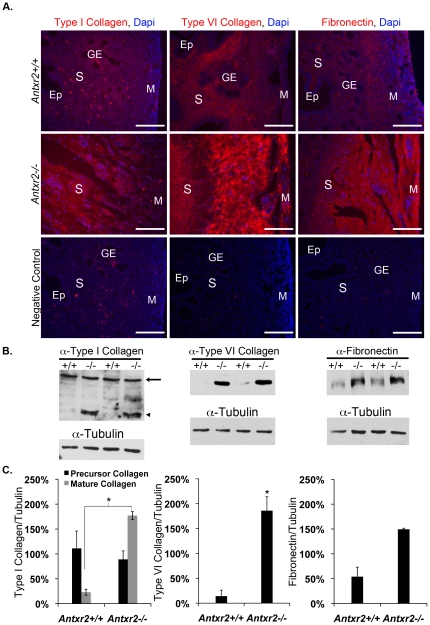
Increased collagen and fibronectin content in aged nulliparous Antxr2−/− uterine tissue.(A) Immunofluorescent staining of uterine tissue isolated from six-month-old mice demonstrated increased type I collagen, type IV collagen and fibronectin deposition in the Antxr2−/− tissue. DAPI (blue) was used for nuclear staining. Negative controls demonstrate specificity of the antibodies. Ep, endometrial epithelium; S, stroma; M, myometrium; GE, glandular epithelium. Scale bars, 150 µm. (B) Uterine lysates from six-month-old mice, Antxr2+/+ (n = 2) and Antxr2−/− (n = 2), were immunoblotted for type I collagen (precursor type I collagen indicated by arrow and mature type I collagen indicated by arrowhead), type VI collagen and fibronectin. Alpha tubulin is shown as a loading control. (C) Densitometric analysis of blots in panel B presented as relative levels of designated ECM protein normalized to respective alpha tubulin. The mean ± the standard deviation are represented, * = P<0.05.